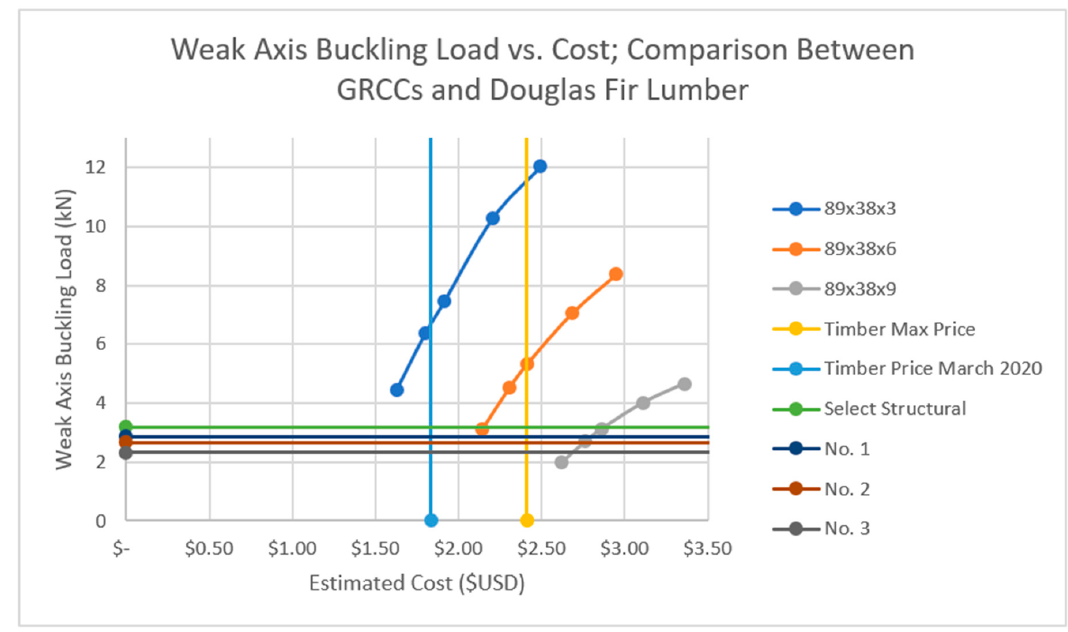
Figure 8. The cost vs. buckling load comparison for the weak axis buckling comparison.